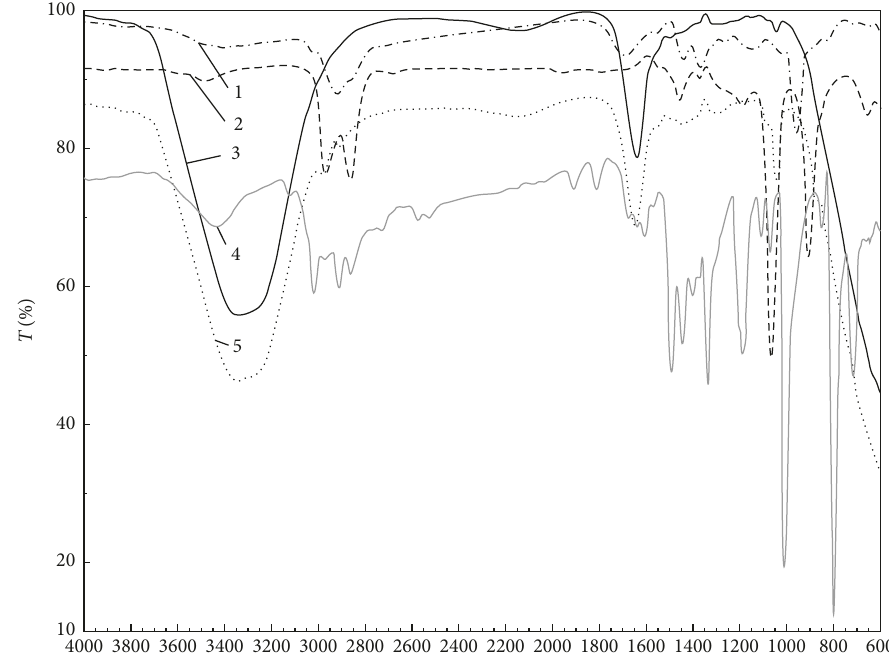
Figure 8: Overlapped IR spectra: β -carotene (line 1); MnTTPCl treated with β -carotene (line 2); n-Au treated with β -carotene (line 3); MnTTPCl (line 4); MnTTPCl/n-Au treated with β -carotene (line